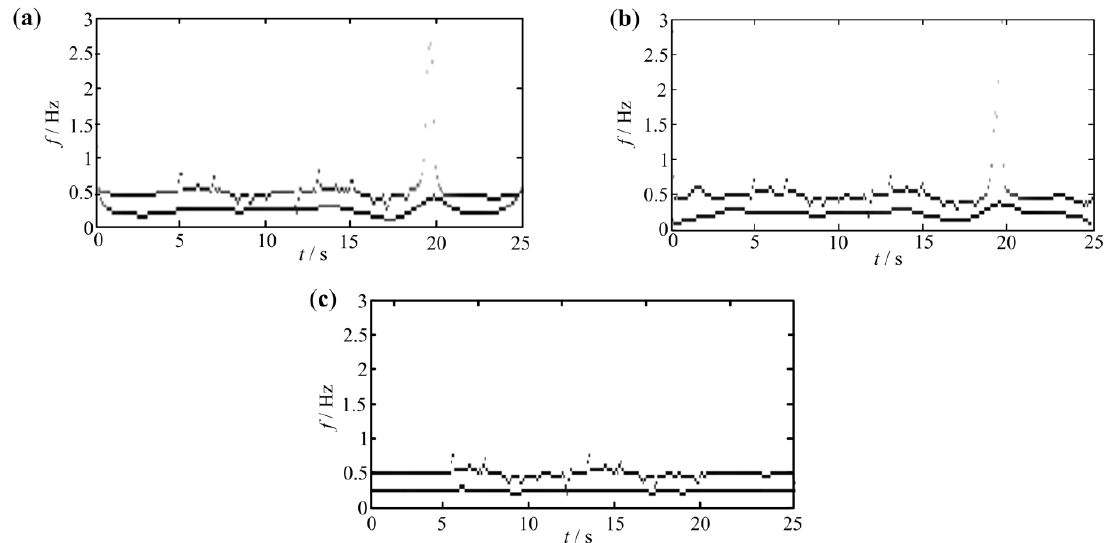
Figure 4. The Hilbert spectra of the IMFs obtained from ( a ) EMD1, ( b ) EMD2, ( c ) EMD3.